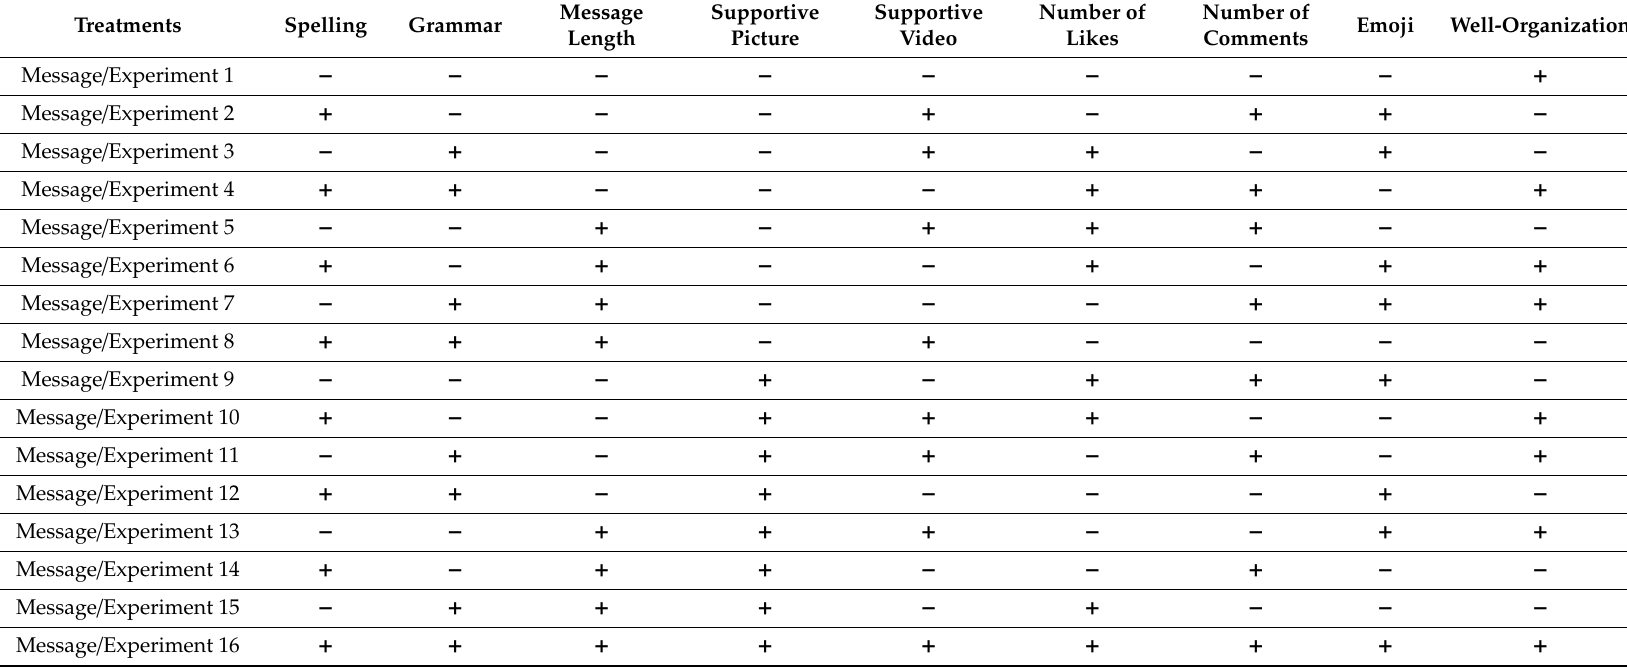
Table 2. The design of the experiments based on fractional factorial design. Number of levels for each factor = 2, number of factors = 9, number of required experiments = 16, and resolution = 3